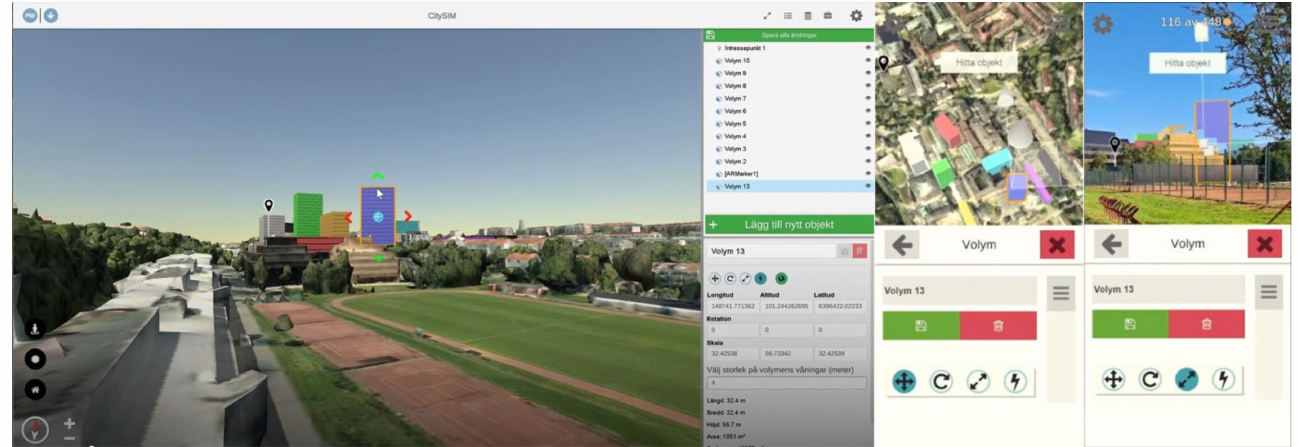
Figure 12. Showing synchronization between the web-based desktop version, scaled MAR and 1:1 on-site